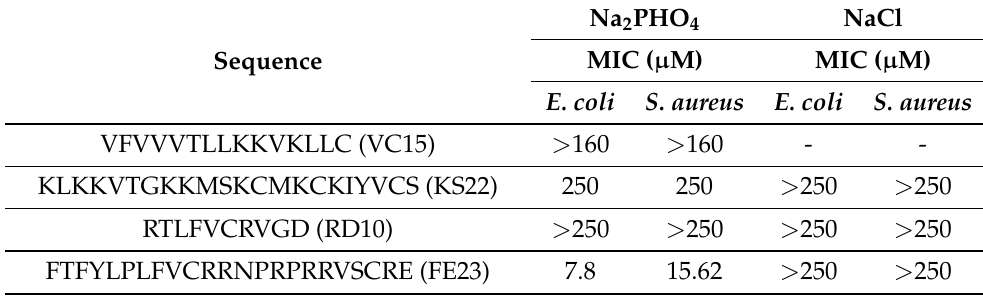
Table 8. Antimicrobial assay. MIC values for the four peptides in Na 2 PHO 4 buffer and NaCl for Gram-negative E. coli and Gram-positive S. aureus